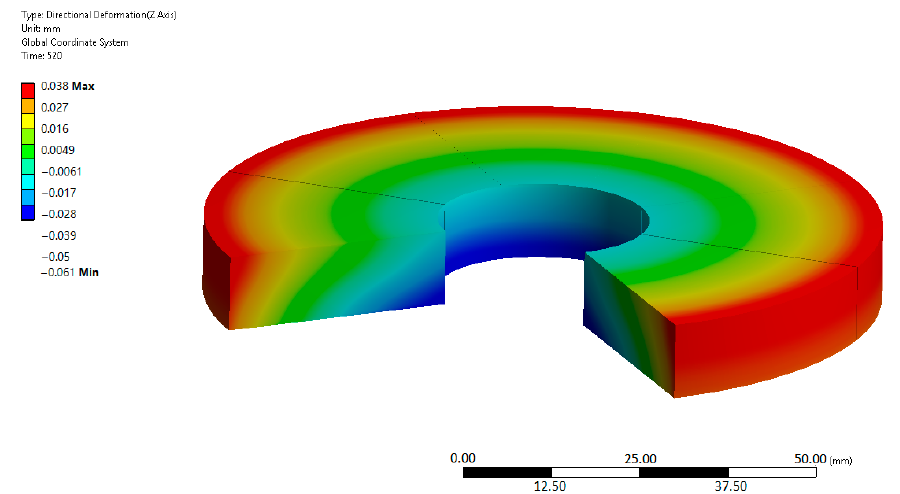
Figure 7. Directional deformation on the cross-section of the analyzed reference disk.